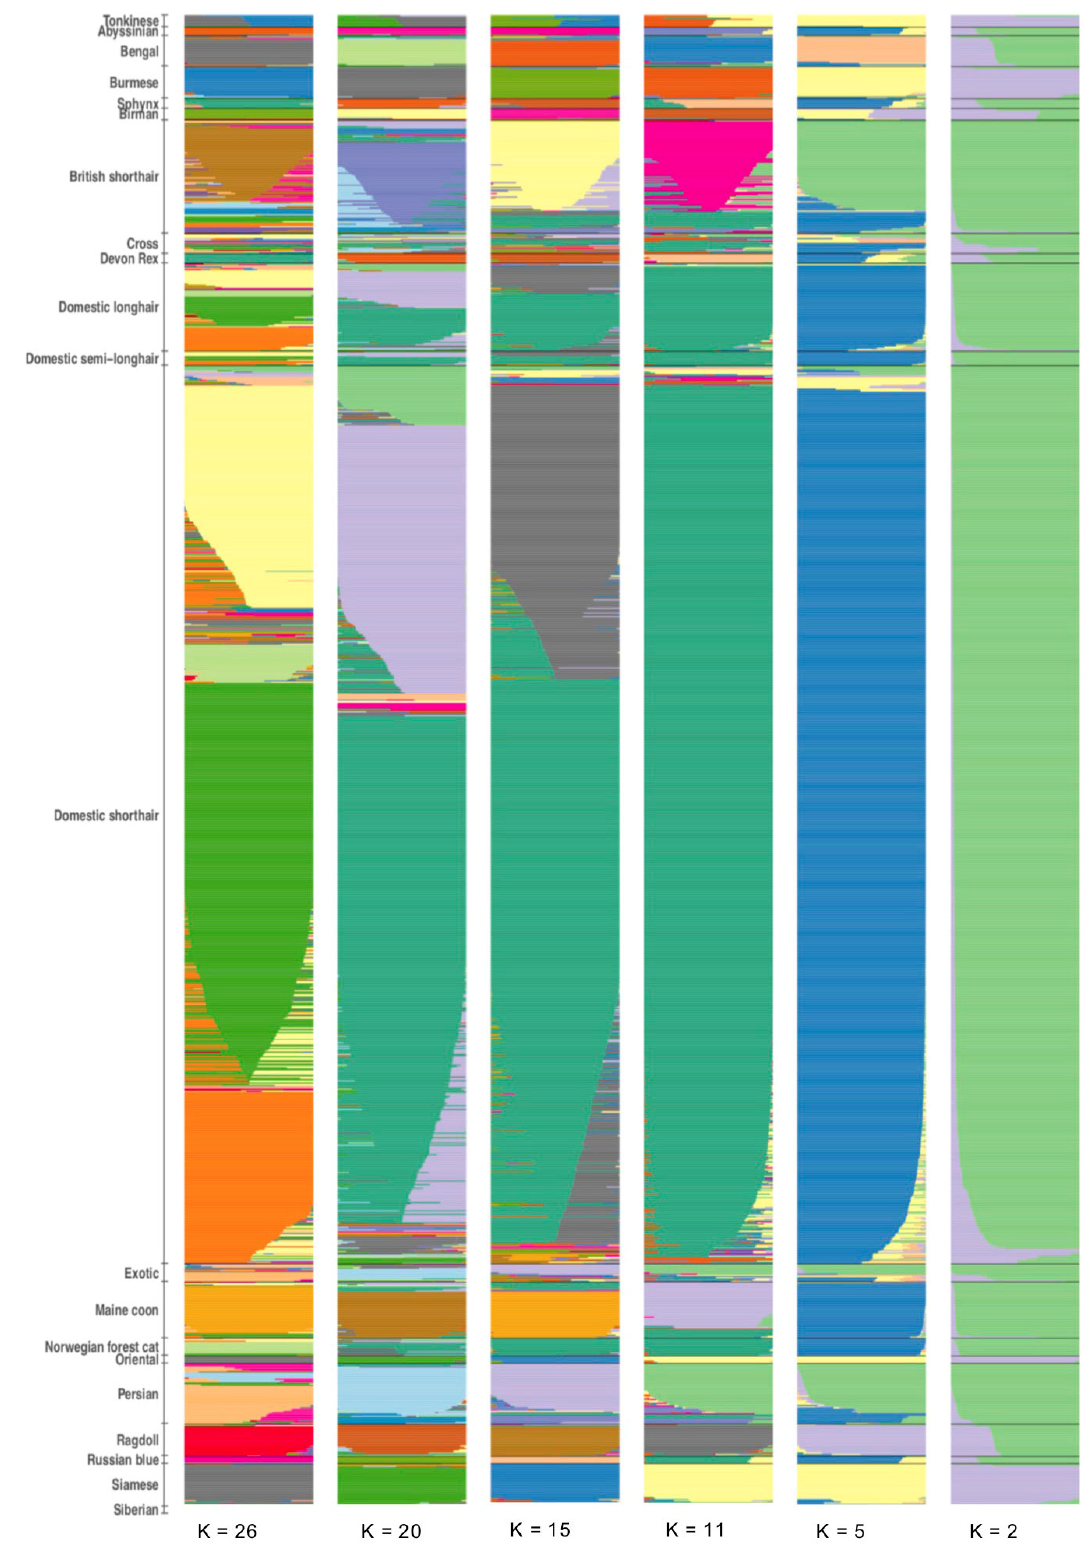
Figure A6. FastSTRUCTURE analysis of the full dataset (showing only breeds with 10 or more samples for display purposes). The model complexity that maximised marginal likelihood was K = 26, whilst model components used to explain structure in the data were K = 11.